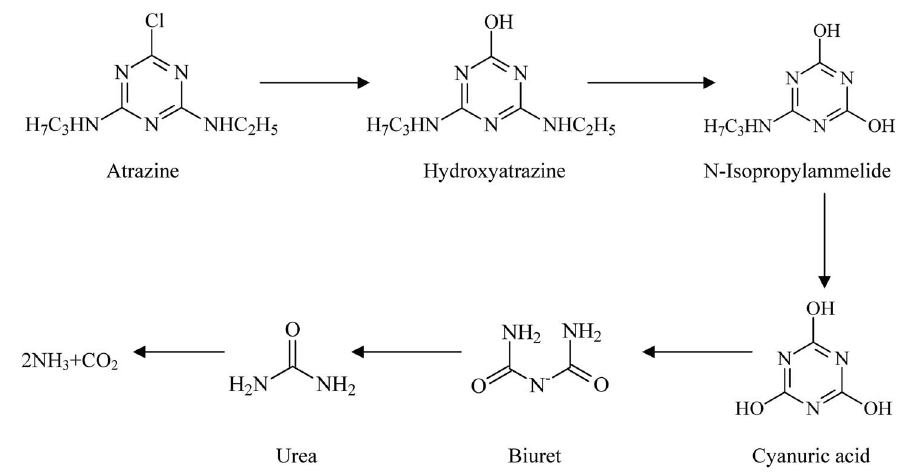
Figure 6. Proposed pathway for degradation of atrazine by strain HB-6.